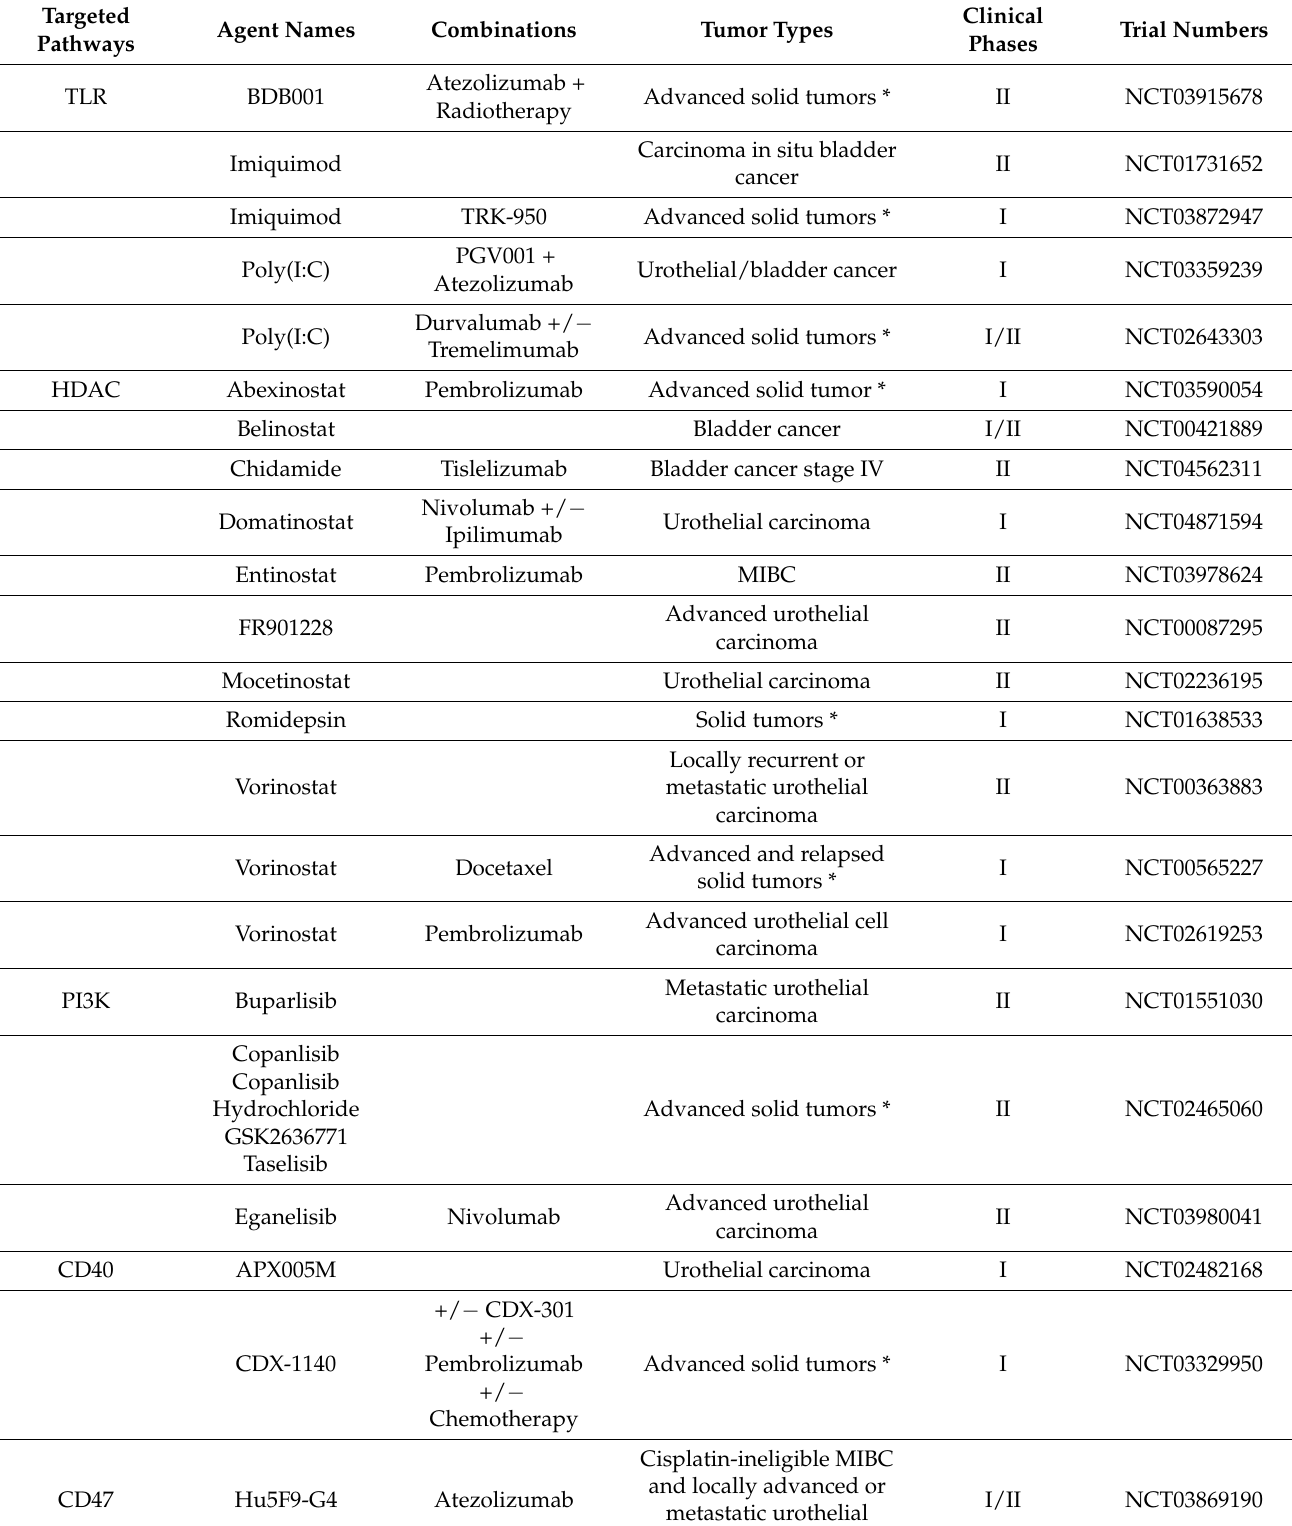
Table 3. Clinical trials including bladder cancer with agents targeting